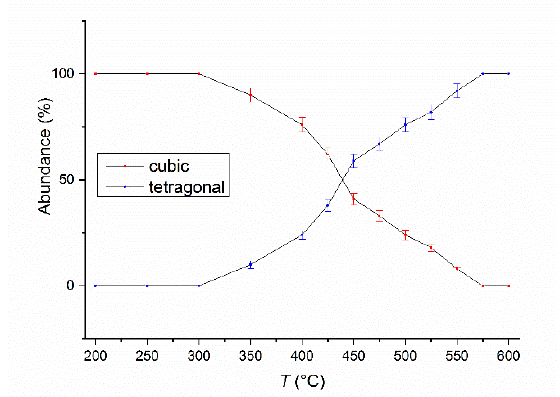
Figure 4. The relative ratio of the cubic and tetragonal phase abundance as a function of temperature, as obtained from the full-profile fitting of the synchrotron X-ray diffractograms.